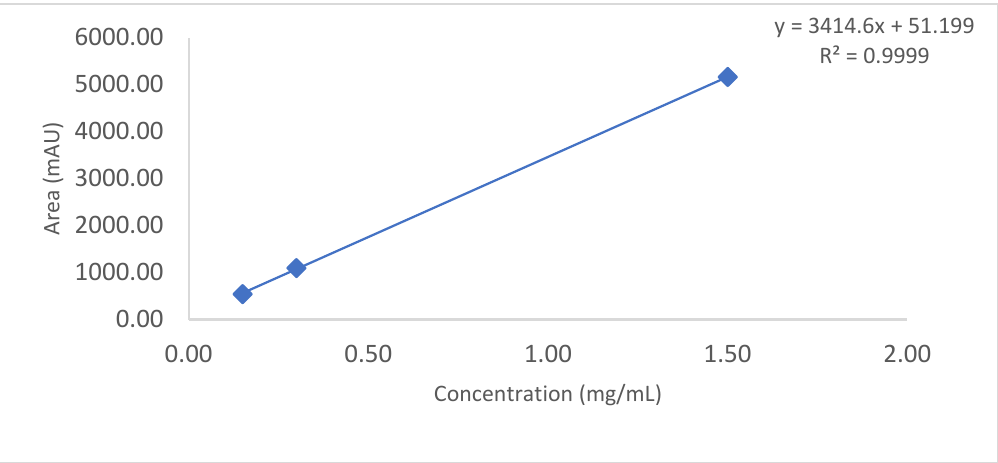
y = 3414.6x + 51.199 R² = 0.9999